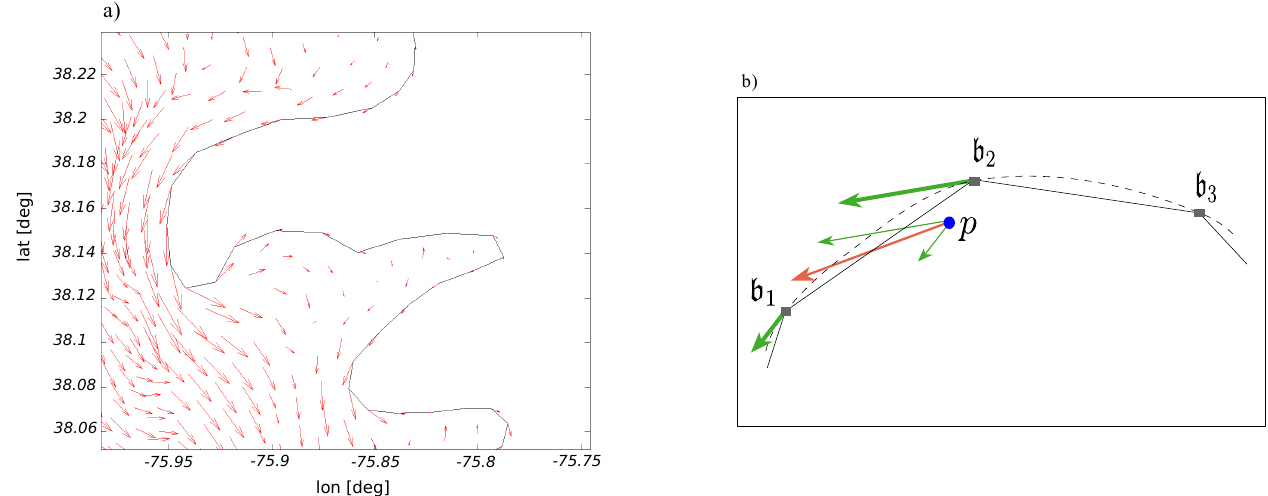
Fig. A2. (a) Example of the instantaneous velocity field in a small region of the Chesapeake Bay in the first sigma layer (i.e. the free surface) which illustrates the effects of imposing the free-slip boundary conditions on a discretized boundary. (b) A schematic illustration of boundary leakage problems which arise when interpolating velocities near a discretized boundary with free-slip boundary conditions.